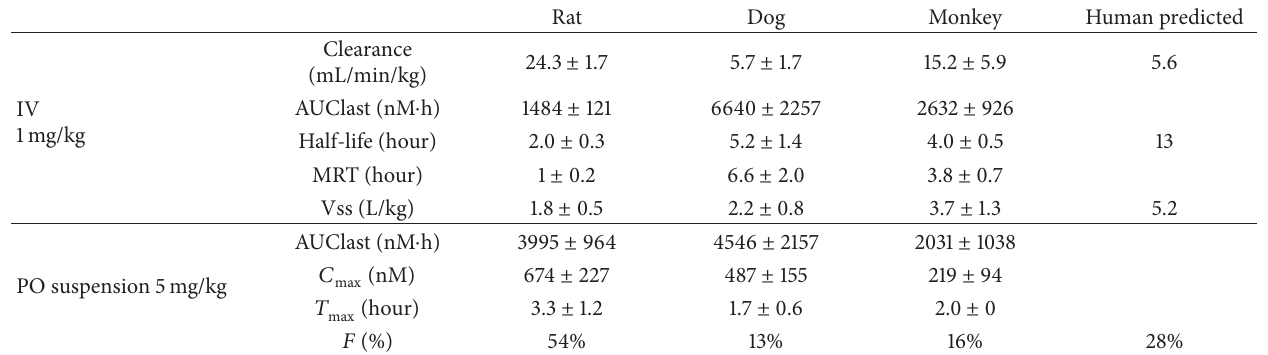
Table 4: Summary pharmacokinetics observed in three species and predicted in human. Rat